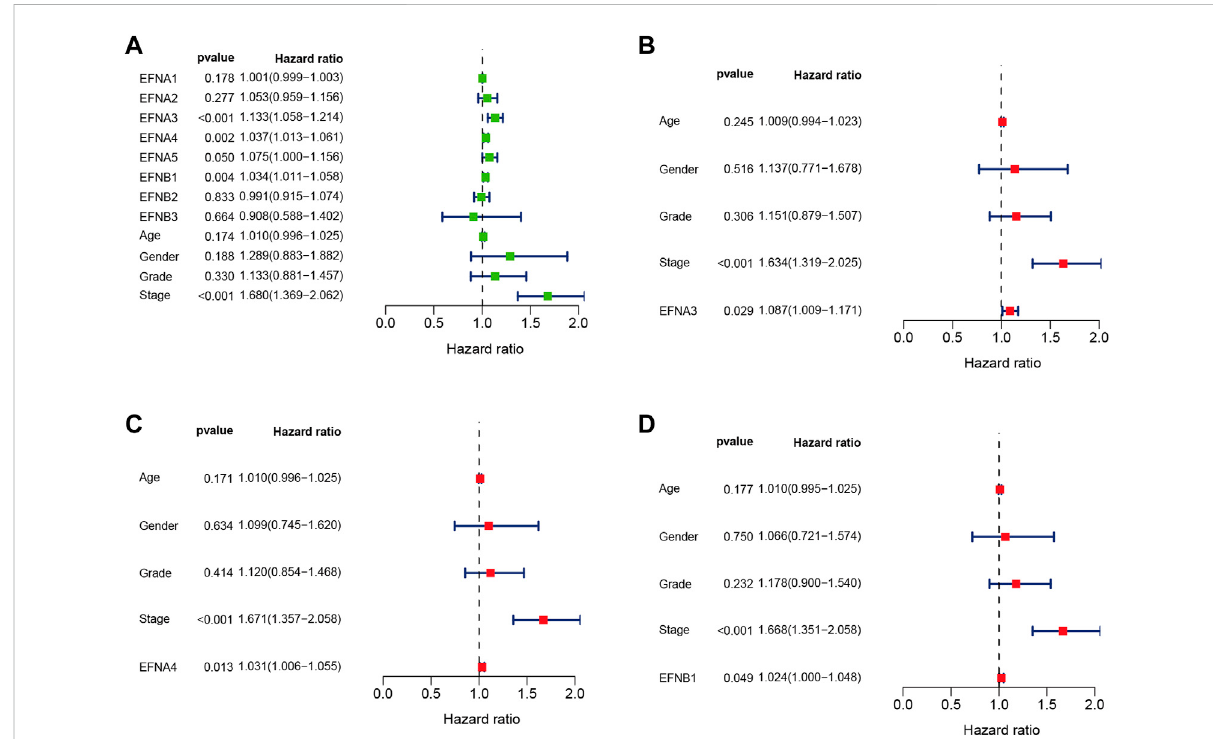
FIGURE 3 Univariate and multivariate CoxregressionanalysesofEFNmembers andclinicopathological parameters inHCCdisplayed withforest plots. (A) Univariate Cox regression analysis of EFNs and clinicopathological parameters. (B – D) Multivariate Cox regression analysis of ephrin members with signi fi cant prognostic signi fi